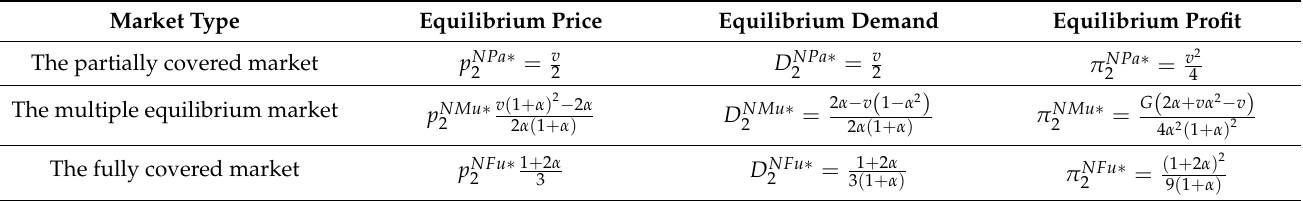
Table 2. The equilibrium price, demand, and profit of the entrant without opening offline stores in the context of different market